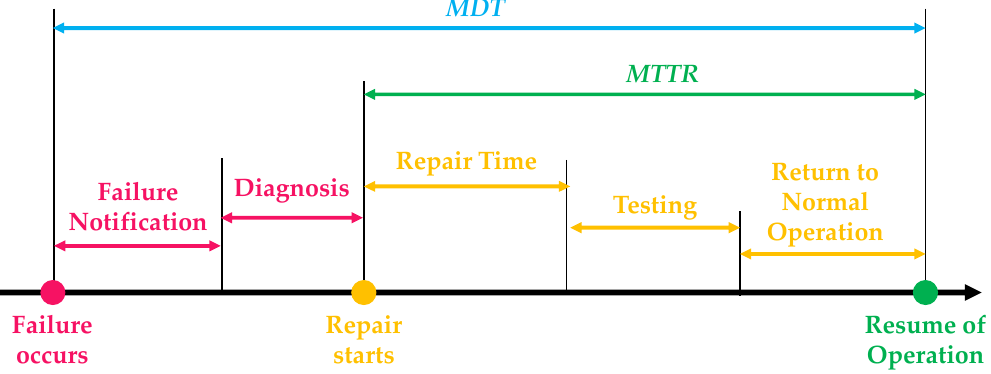
Figure 2. Mean down time and mean time to repair of a generic component.